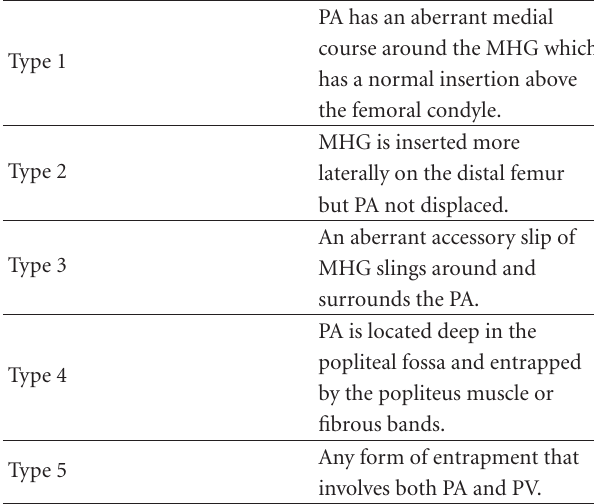
Table 1: Classification of PAES